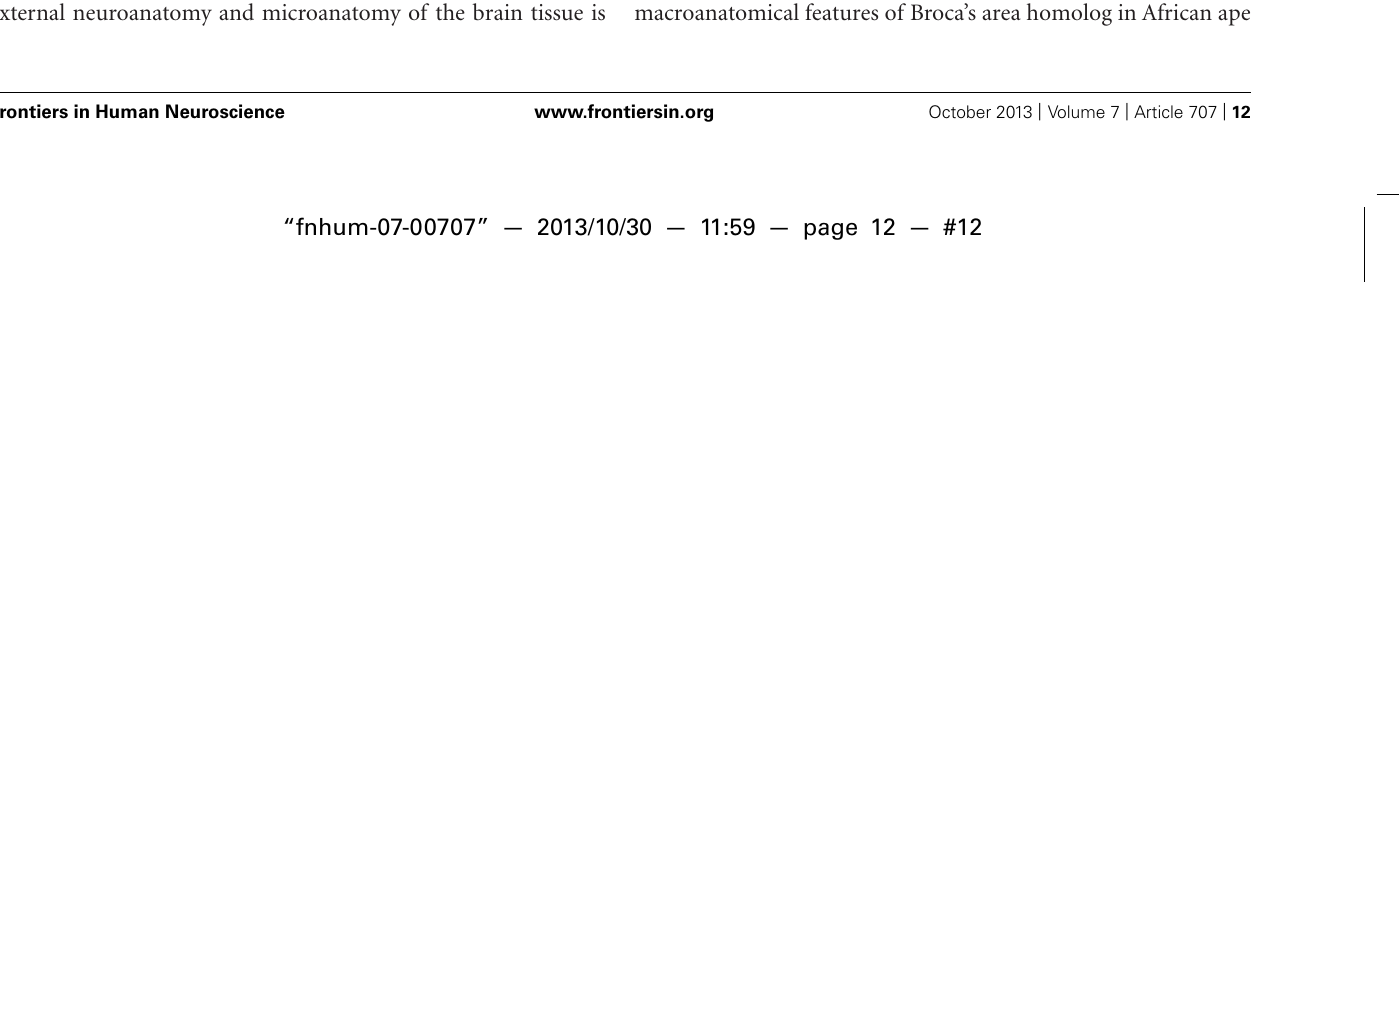
brown; exocranium is white.Top row: exocranium (left) and endocast (middle) are shown transparent. Bottom row: MRI slices reveal internal structures of the brain, meninges, and